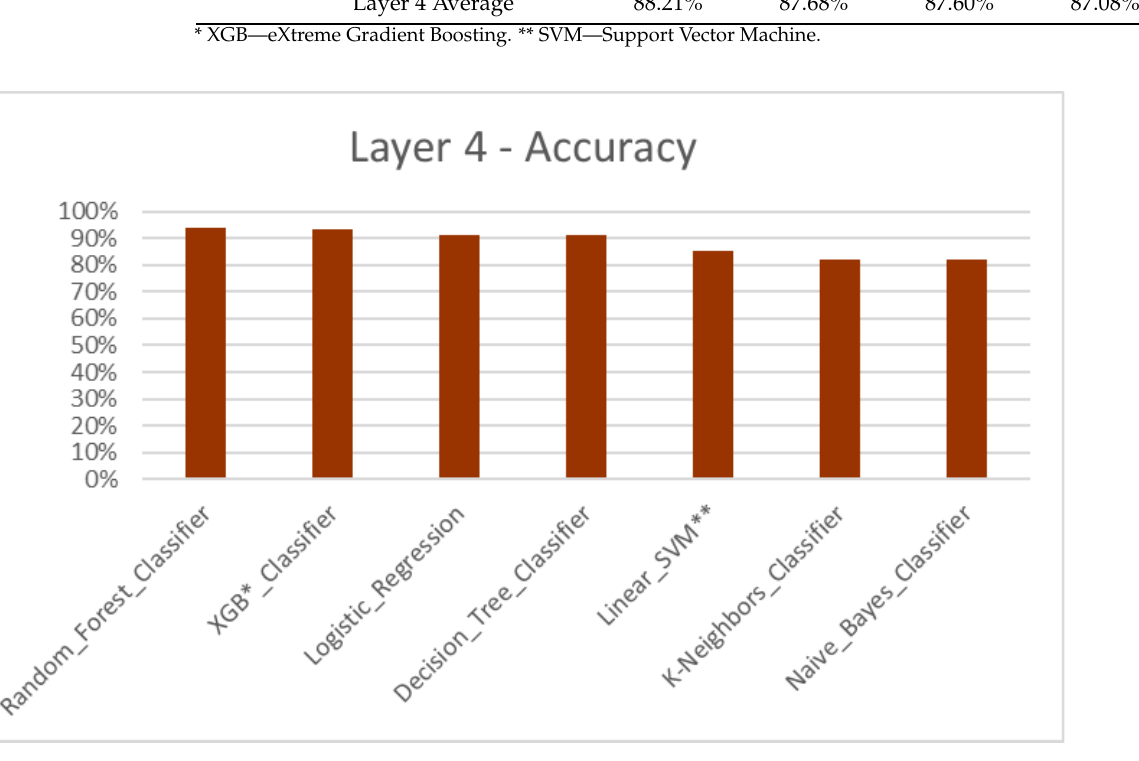
Figure 7. Layer 4 for prediction of growth modulation, camouflage and jaw surgery treatment options for jaw base IV — accuracy. * XGB — eXtreme Gradient Boosting. ** SVM — Support Vector Ma-